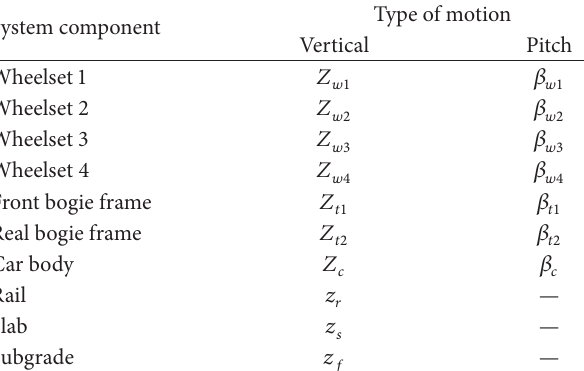
Type of motion Vertical Pitch